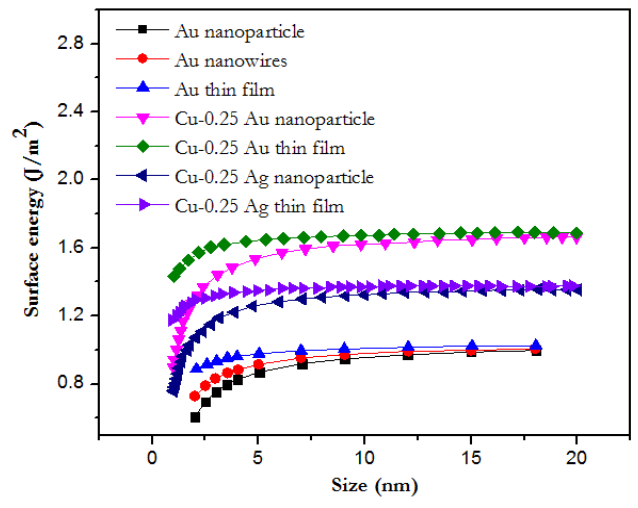
Figure 4. The variation of surface energy with particle size of different shapes [27].